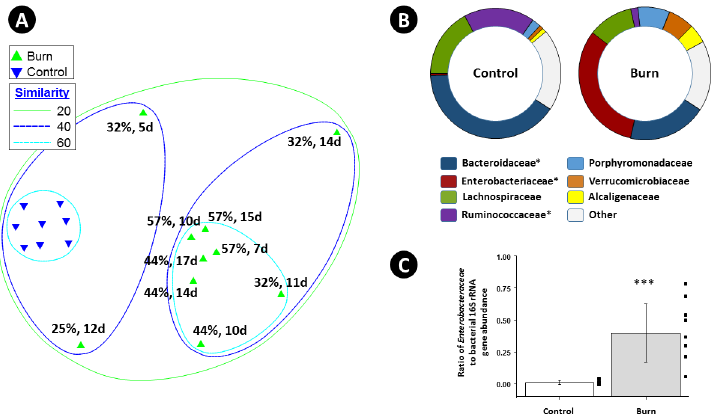
Fig 1. Effects of Burn Injury on Human Gut Microbiome. The non-metric multidimensional scaling (NMDS) plot ( A ) demonstrates the effect of burn injury on the overall human fecal microbial community structure, as assessed by bacterial ribosomal RNA gene amplicon sequencing. The NMDS plot is based on sample-standardized and log transformed abundance data. The NMDS plot and the hierarchical cluster overlay are based on a resemblance matrix calculated using Bray-Curtis similarity. The 2D stress value was 0.10. Fecal samples were taken from eight control patients and from four burn injury patients and analyzed at different time points (days after injury), as indicated in the figure. The most abundant bacterial families in control patients and burn patients are indicated in pie charts (B) , and taxa which were significantly different by Kruskal-Wallis one-way analysis of variance ( * ,FDR-P < 0.05). A box-plot of the distribution of the ratio of rRNA genes from Enterobacteraceae to total bacterial rRNA genes in control and burn patients measured by qPCR is shown (C) , and the ratio of each individual is shown adjacent to the box-plot. A statistically significant effect of burn injury was observed (two-tailed t-test *** , p <